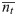
Predictions of SARS-CoV-2 entry into cells with heterogenous protease expression levels.(A, B) The log-normal distribution of TMPRSS2 (A) and Cathepsin B/L (B) across cells. Dependence of the susceptibility of infection through the TMPRSS2 pathway on the TMPRSS2 expression level, nt, (A) and through the Cathepsin B/L pathway on the Cathepsin B/L expression level, nc (B). (C) The joint distribution of cells expressing both TMPRSS2 and Cathepsin B/L. (D) Dependence of susceptibility of infection on both TMPRSS2 and Cathepsin B/L expression levels. In (A)-(D), nt¯ = 11.5 and nc¯ = 11.5. (E) The log-normal distribution of TMPRSS2 across cells with low (nt¯ = 10), medium (nt¯ = 11.7) and high (nt¯ = 12.4) mean TMPRSS2 expression levels. (F, G) Infected cells in the absence of inhibitors (F) and fraction of infection events uninhibited by different concentrations of a Cathepsin B/L inhibitor (G) at different mean TMPRSS2 expression levels and fixed mean Cathepsin B/L expression (nc¯ = 11.5). (H) The log-normal distribution of Cathepsin B/L across cells with low (nc¯ = 10.7), medium (nc¯ = 12.4) and high (nc¯ = 13.1) mean Cathepsin B/L expression levels. (I, J) Infected cells in the absence of inhibitors (I) and fraction of infection events uninhibited by different concentrations of TMPRSS2 inhibitor (J) at different mean Cathepsin B/L expression levels and fixed mean TMPRSS2 expression (nt¯ = 11.5). In (F), (G), (I), and (J), the cumulative level of infection was computed at day 1 post infection, and the drug concentrations were normalised by the respective γ values (Methods). The other parameters and initial conditions are listed in S1 Table.